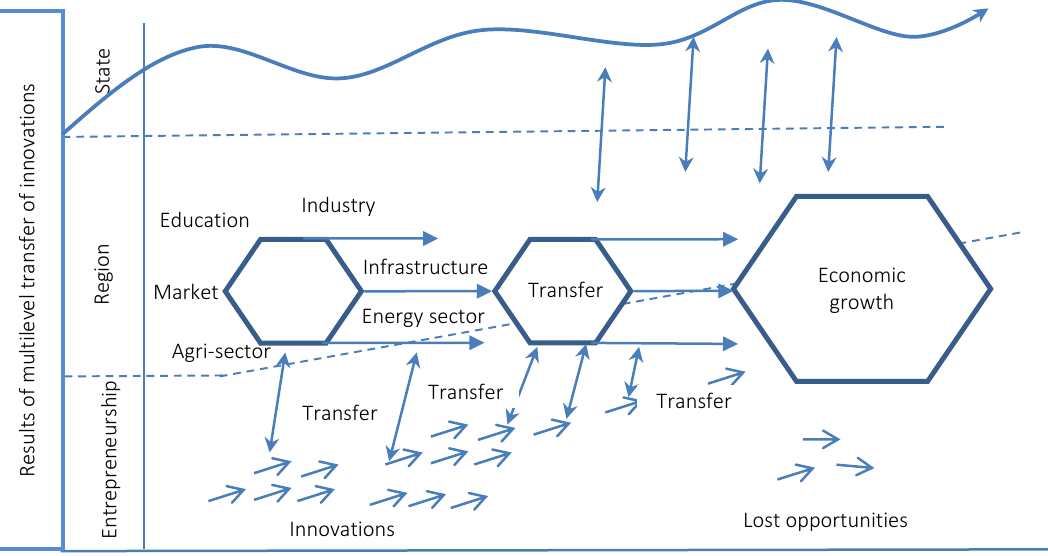
Figure 1. Multilevel and intersectoral transfer of innovations (authors’